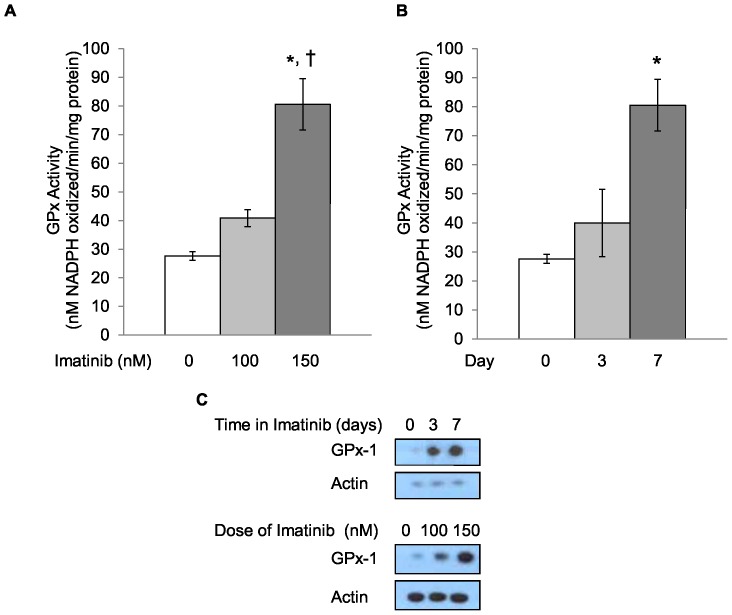
GPx-1 levels are enhanced in a dose- and time-dependent manner following imatinib treatment.The dose- and time-dependent increases in GPx activity following 100 nM and 150 nM imatinib treatment of KU812a cells for 7 days (A) or 150 nM imatinib treatment for 3 or 7 days (B). The effect of imatinib treatment on GPx1 protein levels. Data shown is representative of thee independent experiments were performed (C). * = P<0.001, † = P<0.05, compared to 100 nM or 3-day imatinib treatment. Error bars indicate S.D.